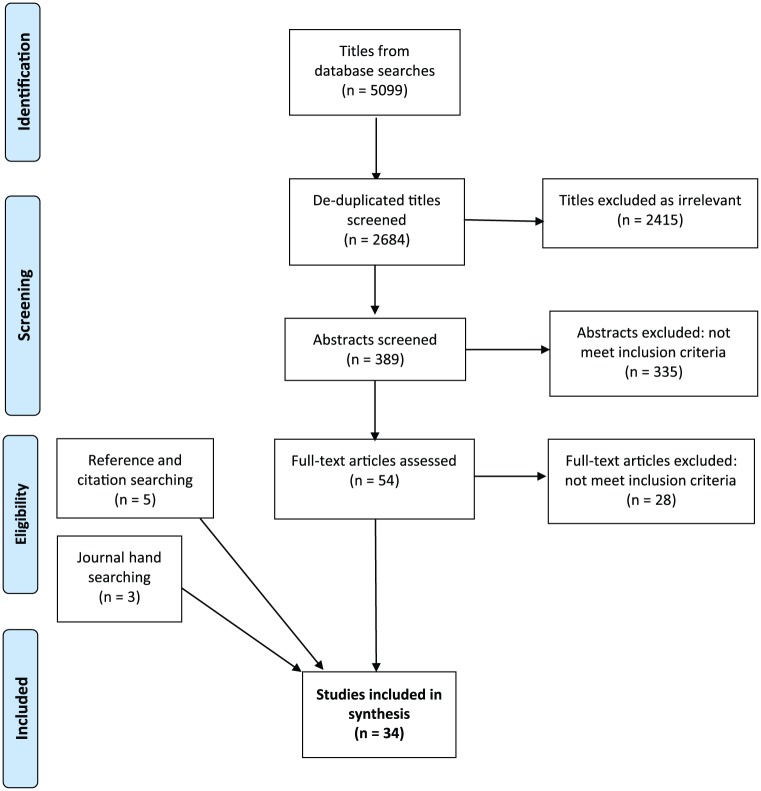
PRISMA flow diagram.